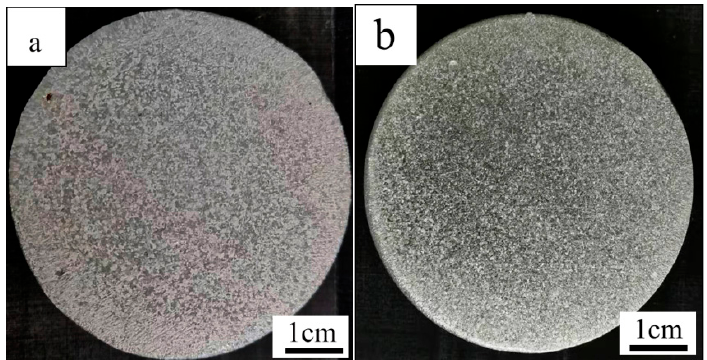
Figure 8. Macrographs of the industrial aluminum refined by different refiners. ( a ) Al-TiO 2 -C- 0.2La 2 O 3 refiner; ( b ) Al-5Ti-B refiner.